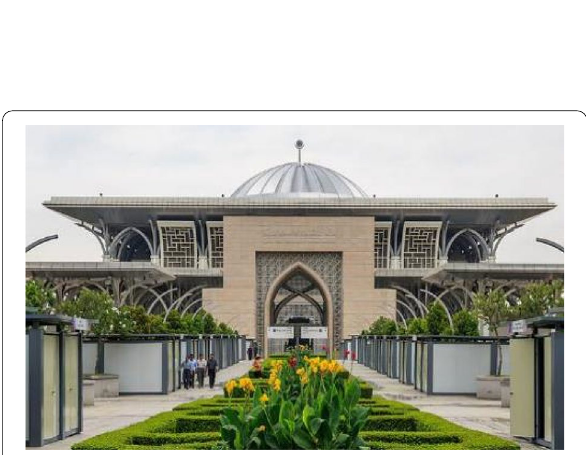
Fig. 11 The exterior of Masjid Tuanku Mizan Zainal Abidin (Uwe Aranas,